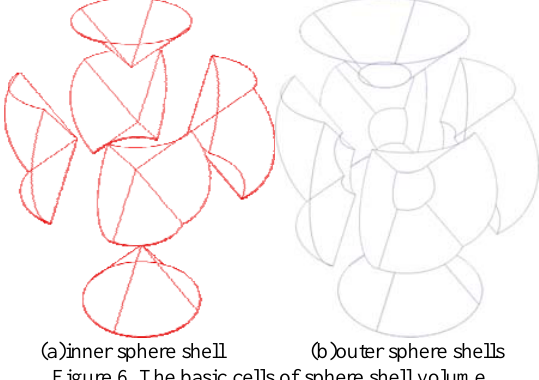
Figure 6. The basic cells of sphere shell volume.